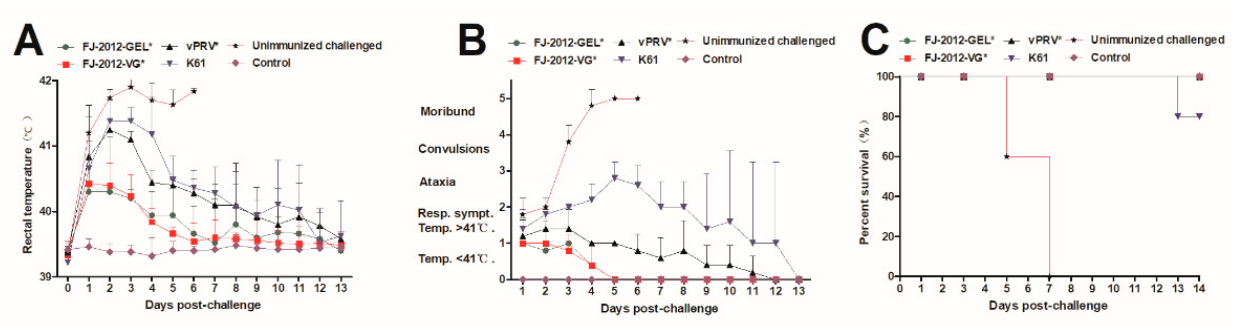
Figure 3. Protection efficacy of different vaccines against PRV FJ-2012 challenge in piglets. ( A ) Rectal temperature of piglets after challenging with FJ-2012. ( B ) Clinical scores with mean values and standard deviation. ( C ) Percentage survival curve of piglets vaccinated with a different vaccine. Survival is presented as a Kaplan–Meier plot ( n = 5 per group). The “*” mark in the group top right indicates an inactivated vaccine.